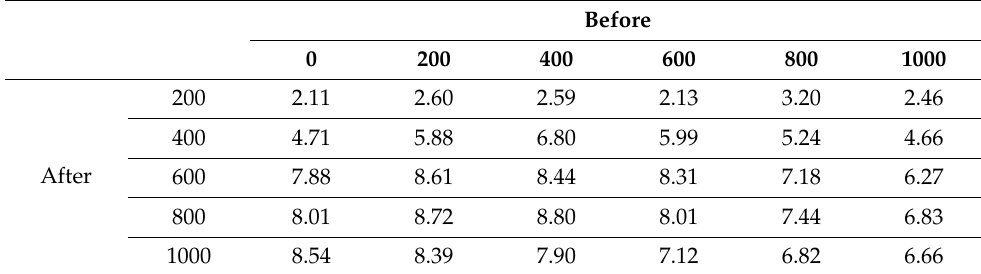
Figure 9. Questionnaire results of perceived naturalness in the expriment II. ( a ) the male model (android), ( b ) the female model (android). Table 11. The perceived naturalness of the male model (android).